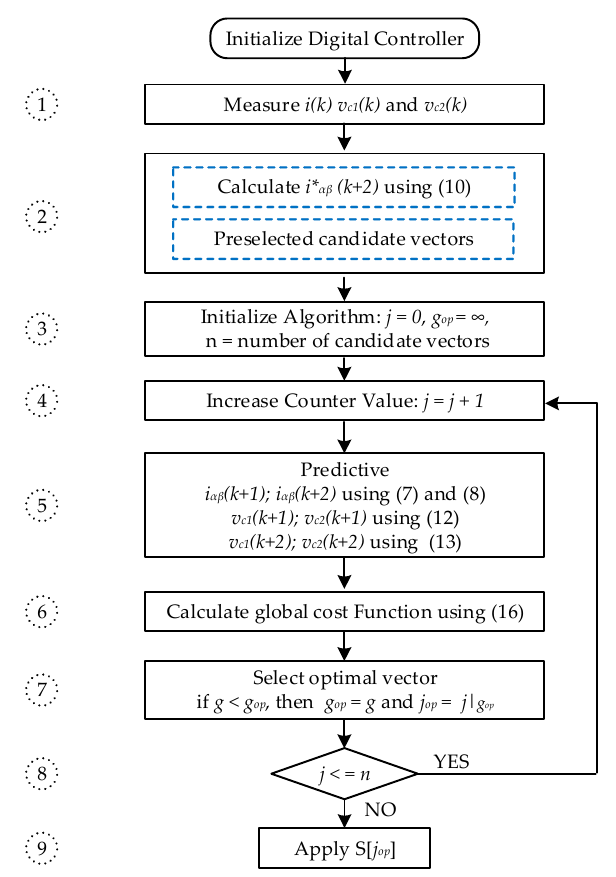
Figure 7. Implementation of improved MPC for the asymmetric T − type NPC inverter.